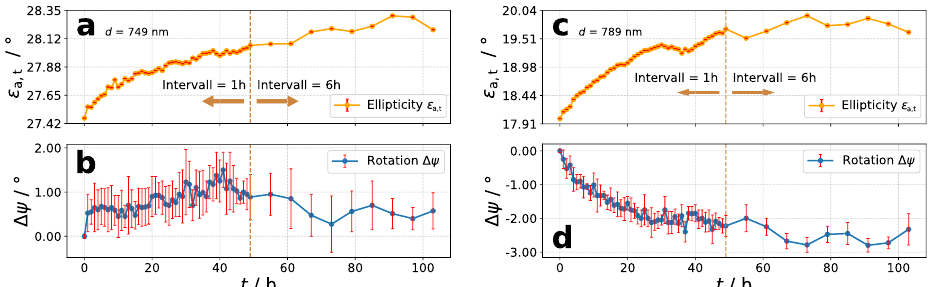
Figure 8. Polarimetric measurements with the ellipticity-combination of (cid:101) ( 2 ) for 48 h in 1 h-steps and further 72 h in 6h-steps. ( a , b ): Polymer P2 , d = 749nm; ( c , d ): Polymer P3 , d =